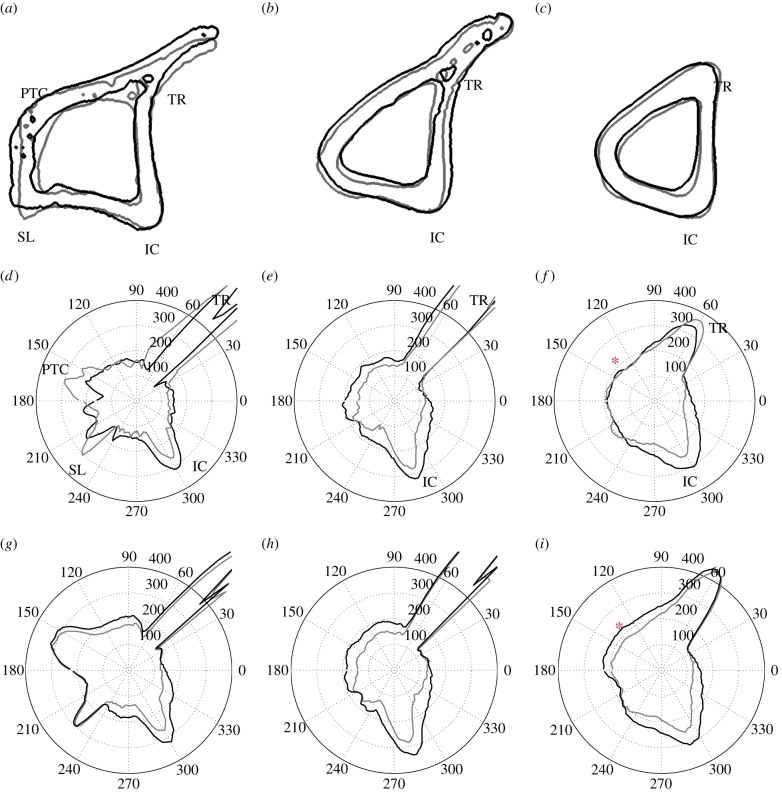
(a–c) Cross-sectional contours of left (non-loaded, grey line) and right (loaded, black line) tibiae, and respective polar representation cortical thickness, Th, for (d–f) the in vivo data measurements and (g–i) predictions using ΨA = 50 MPa. The red asterisk (c and i) is placed at Z = 0.7 and θ = 135° and highlights a region where in silico adaptation was overestimated (Th units in micrometres). (a) Z = 0.3, (b) Z = 0.5, (c) Z = 0.7; (d) micro-CT scan, Z = 0.3, (e) micro-CT scan, Z = 0.5, (f) micro-CT scan, Z = 0.7; (g) simulation, Z = 0.3, (h) simulation, Z = 0.5 and (i) simulation, Z = 0.7.